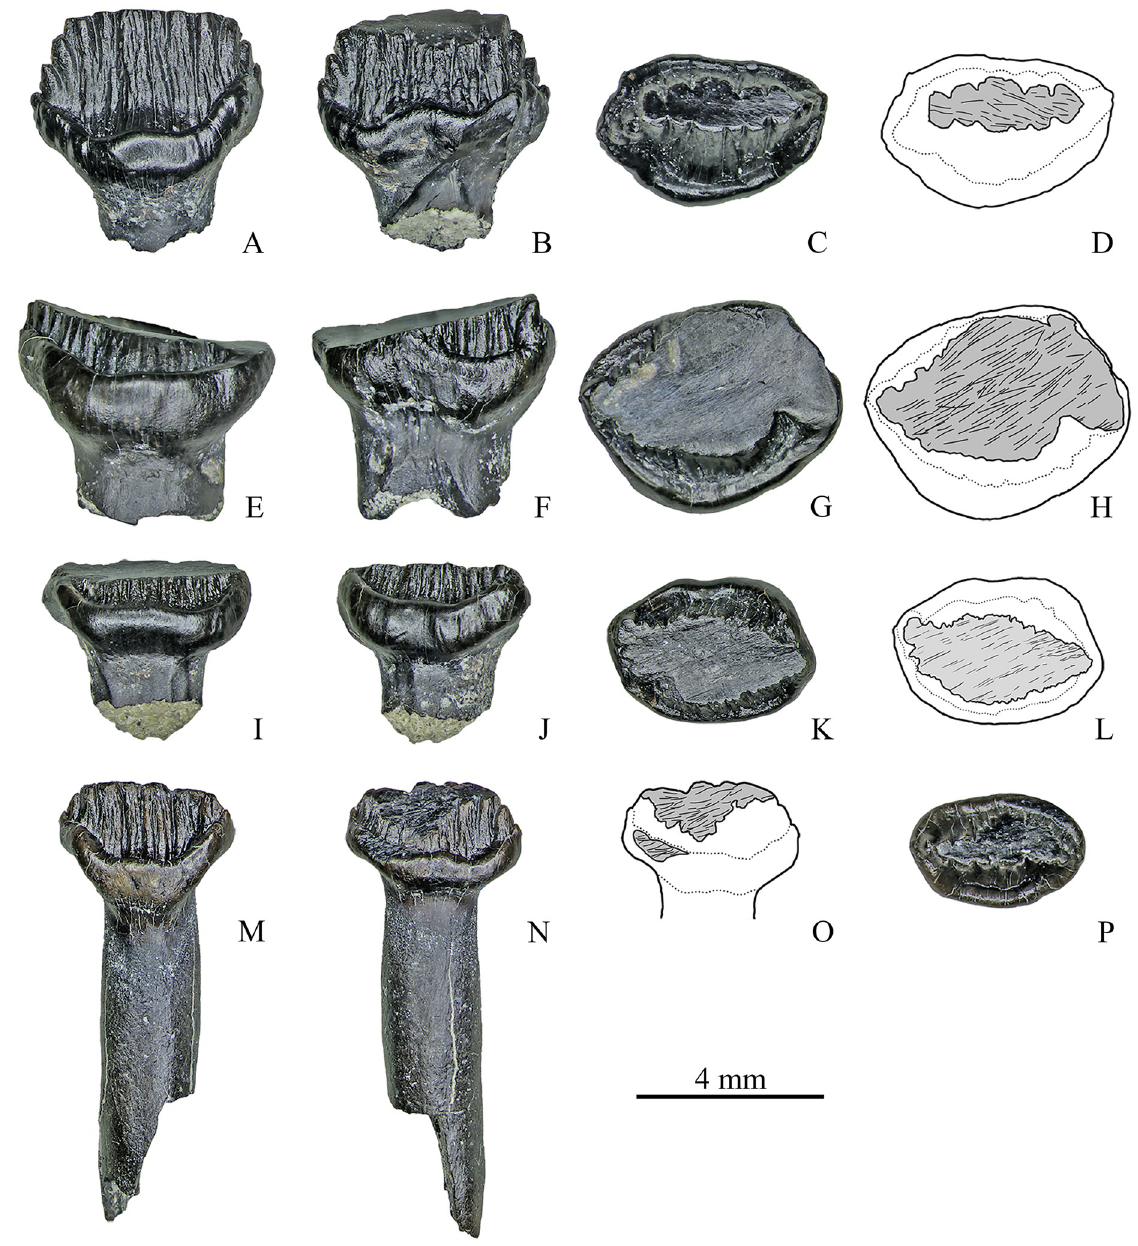
Fig 3. Maxillary teeth with a single apical facet of Stegosauria indet. from the Teete locality, Yakutia, Russia; Batylykh Formation (Lower Cretaceous). Specimens ZIN PH 7/246 (A–D), ZIN PH 11/246 (E–H), ZIN PH 20/246 (I–L), ZIN PH 6/246 (M–P) in labial (A, E, I, M), lingual (B, F, J, N), occlusal (C, G, K, P) views, and interpretive drawings in occlusal (D, H, L) and lingual (O) views showing the wear facets with